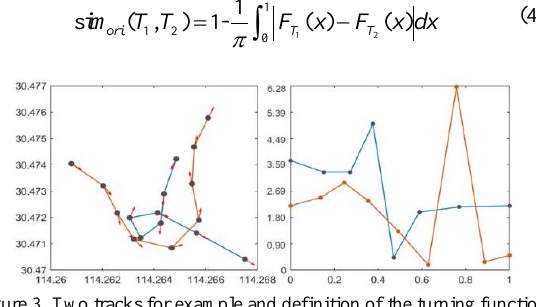
Based on the clusters of different turning modes, the turning